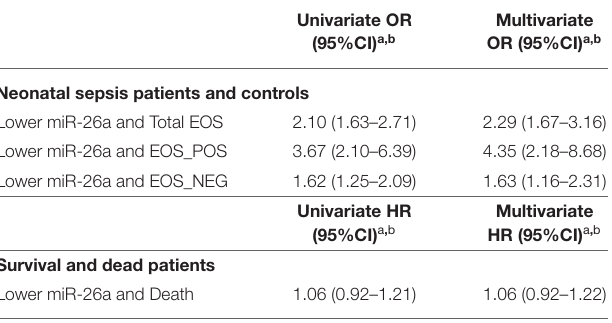
TABLE 2 | Association of baseline miR-26a in peripheral blood mononuclear cells with early-onset neonatal sepsis or